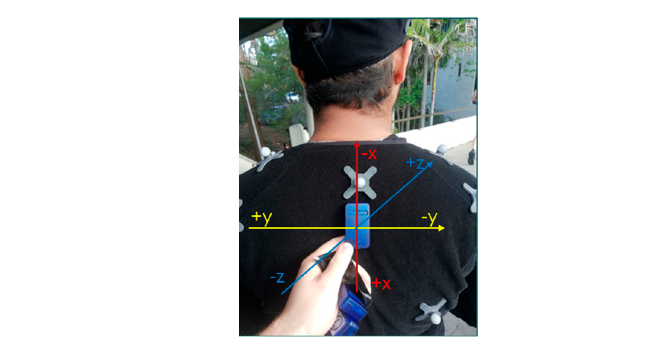
Figure 2. Retro-reflective markers and inertial measurement unit (IMU) sensors on the bowler’s body.